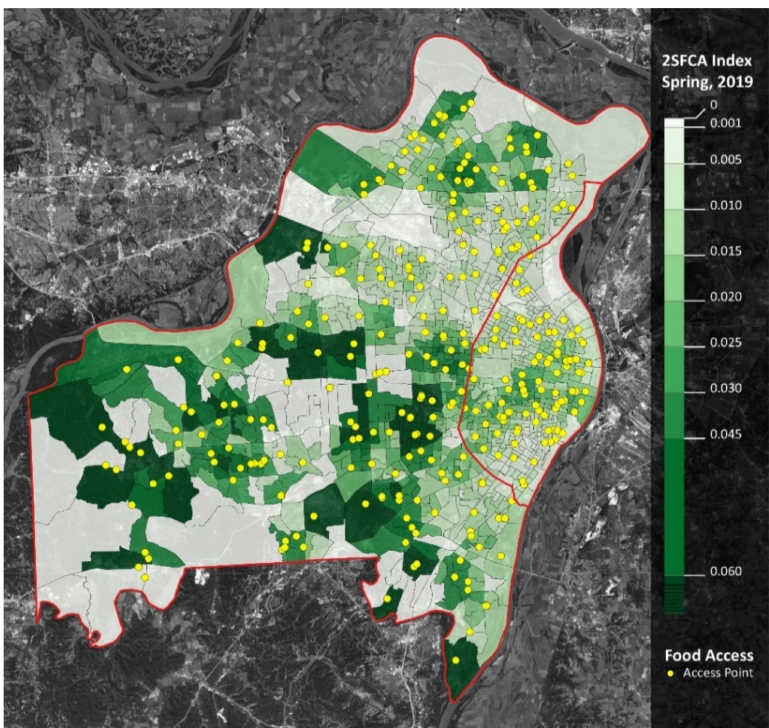
Figure 3. Meal accessibility (2SFCA Analysis): spring 2019. Notes: St. Louis City is the area east of the red line. St. Louis County is the area west of the red line. Yellow dots represent meal access points. Darker shades of green represent greater accessibility.